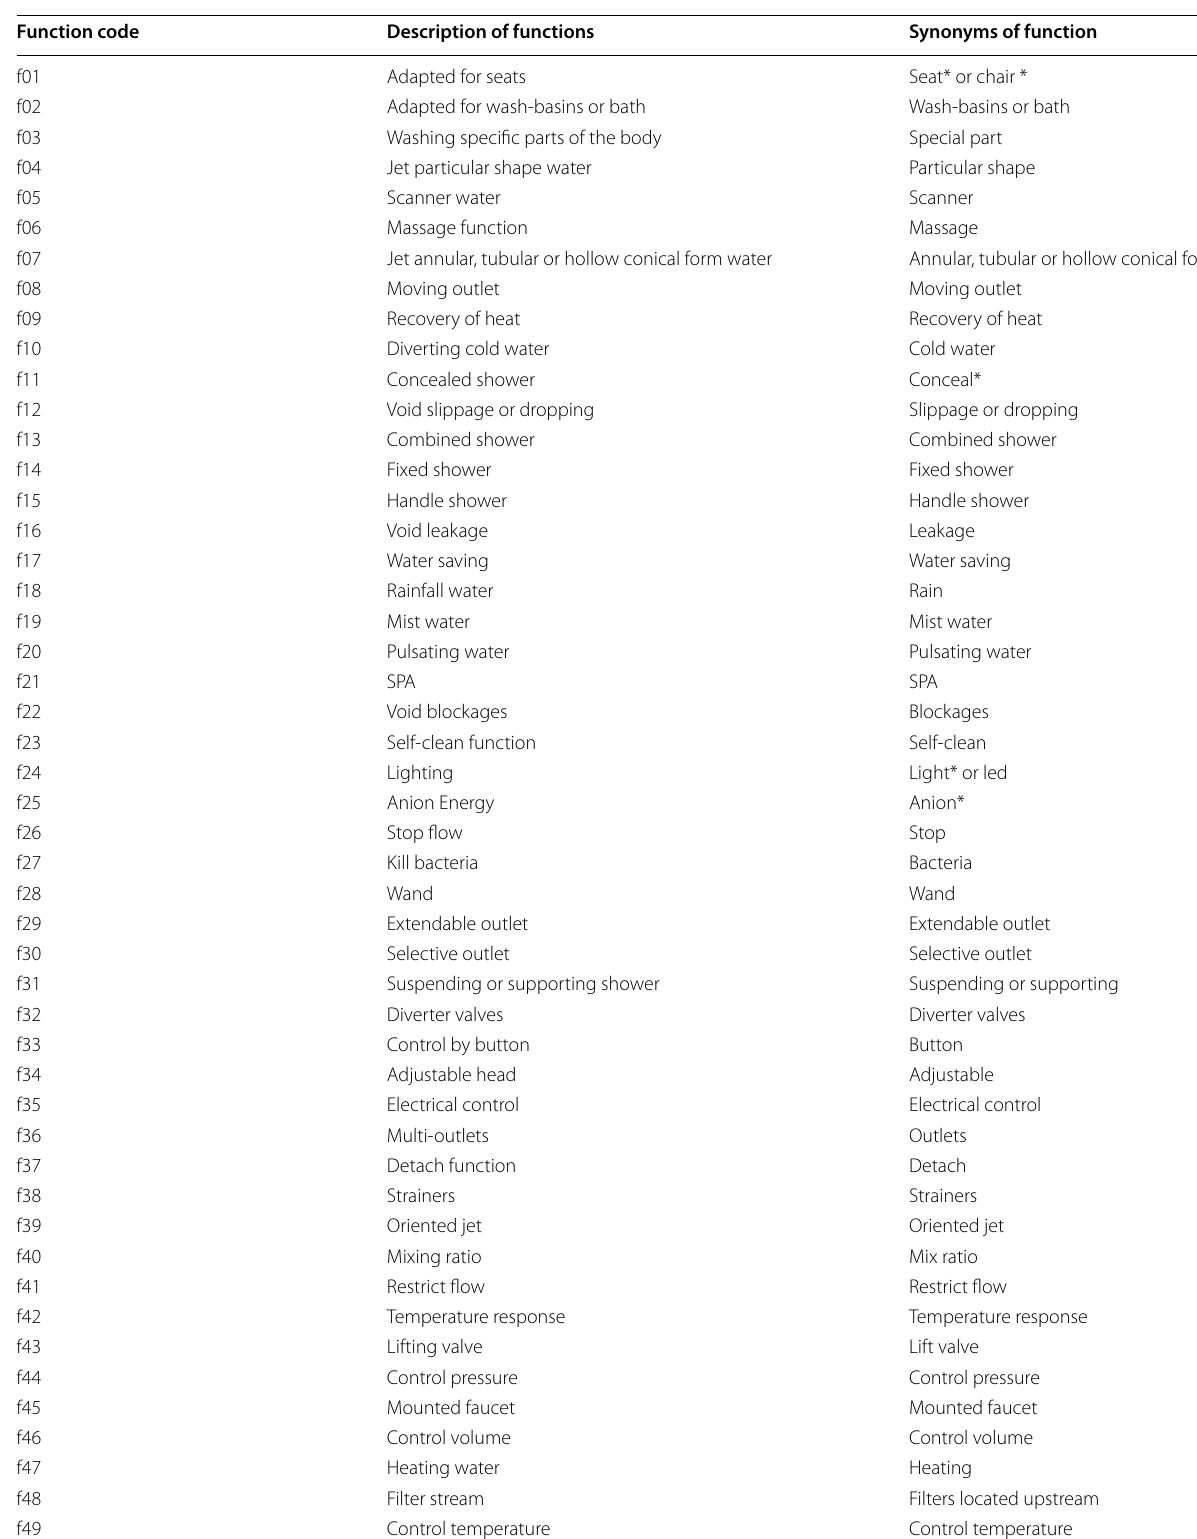
Table 2 List of